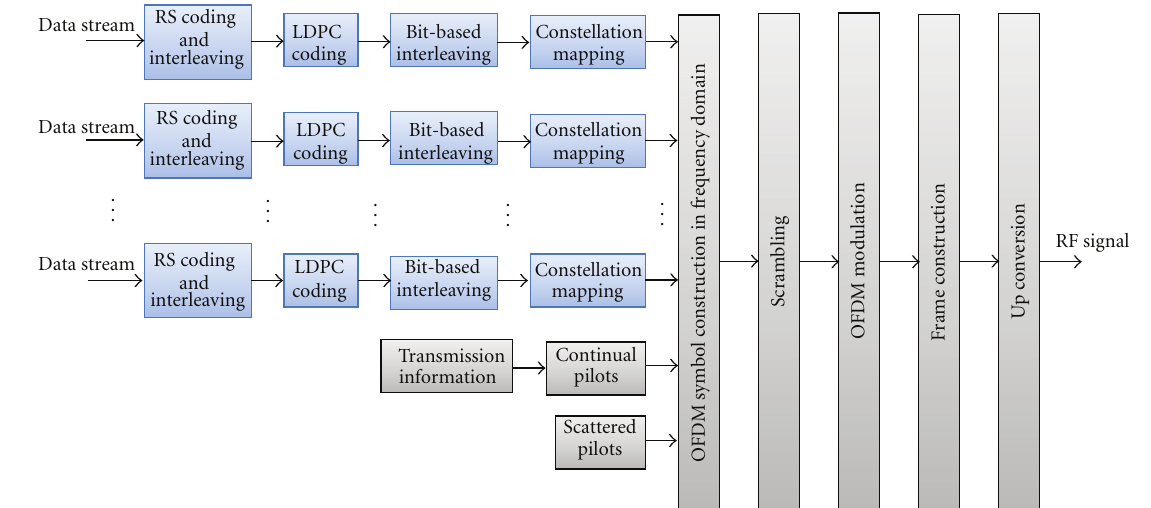
Figure 3: CMMB transmitter